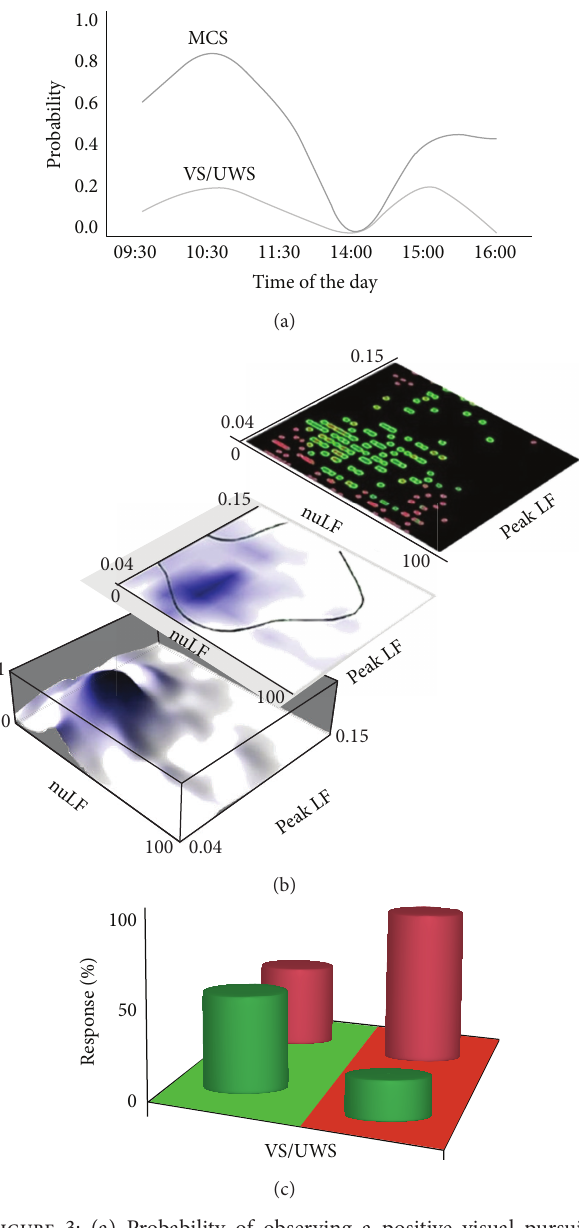
Figure 3: (a) Probability of observing a positive visual pursuit response over time during the day in VS/UWS and MCS subjects repeatedly tested (6 tests/subject/day). Maxima are at approximately 10.00 a.m. and 3.00 p.m., while no response was observed at postprandial time (after Candelieri et al., 2011 [41], modified). (b) Top right: scatterplot of positive visual pursuit responses (green) and no observed responses (red) in a group of DOC subjects versus the values of the HRV descriptors nuLF and pkLF ; middle: support vector machine model predicting the target data values (presence or absence of a pursuit response) to which specific attributes (the HRV descriptors) could be related; bottom left: probability of observing a pursuit response estimated as the relative frequency of response for each subject versus each HRV descriptor (after Riganello et al., 2013 [39], modified). The overall incidence of positive responses or no response at all is summarized in the inset at (c), where the model areas at which a response could or could not be predicted by HRV estimates are in green and red, respectively, and the actual percentage of responses/no responses is